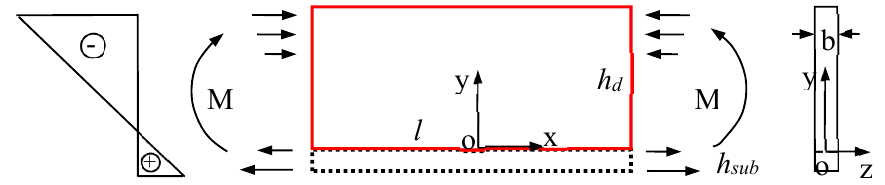
Figure 1. Schematic illustration of the simplified two-dimensional elastic plane.